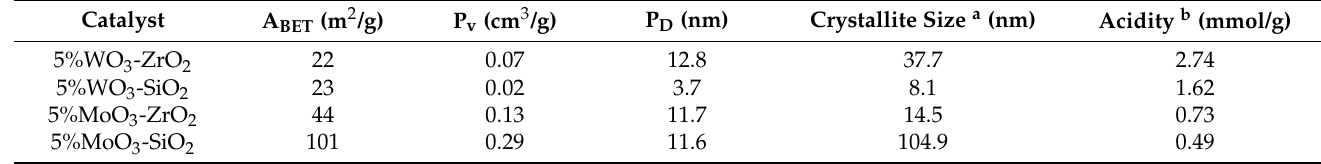
Figure 1. Textural characteristic plots of the as-synthesized MMO; ( a ) BJH desorption pore volume (P V ) distribution, ( b ) N 2 sorption isotherms, ( c ) Low-angle p-XRD, and ( d ) Wide-angle p-XRD. Table 1. Textural characterization and p-XRD data of the as-synthesized